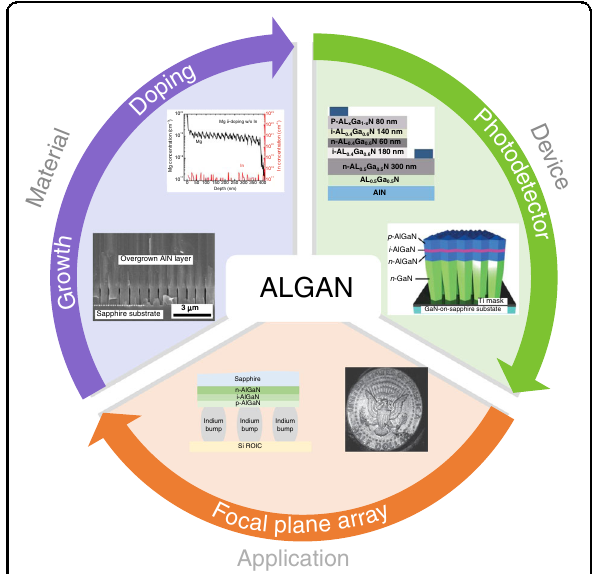
Fig. 1 Diagram of this review. Including the material section (AlGaN growth and doping), device section (AlGaN solar-blind photodetector), and application section (AlGaN focal plane